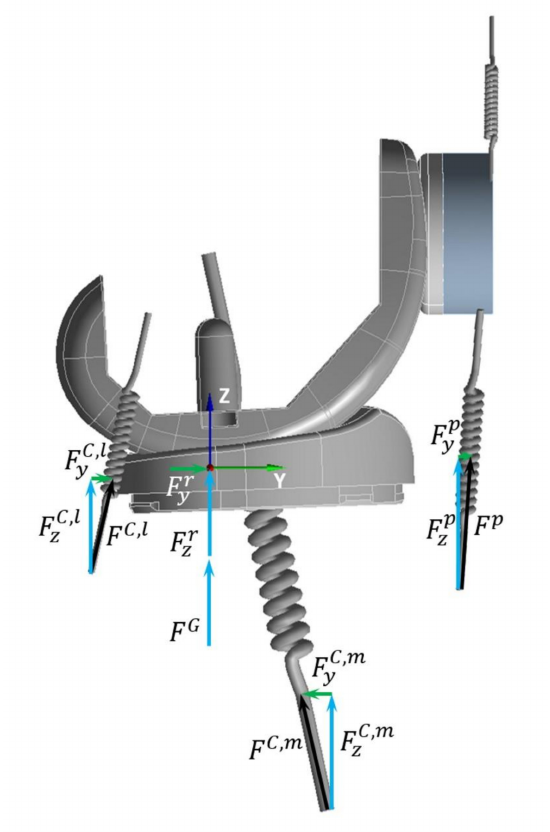
Figure 2. Tibial forces (black) and their components in y (green)- and z (blue)-directions, respectively. There are two main contact areas in the knee joint which had to be taken into account. Both the tibiofemoral and the patellofemoral contact areas were modeled as asymmet- ric augmented Lagrangian contacts. A coefficient of friction of 0.05 was used for this simulation